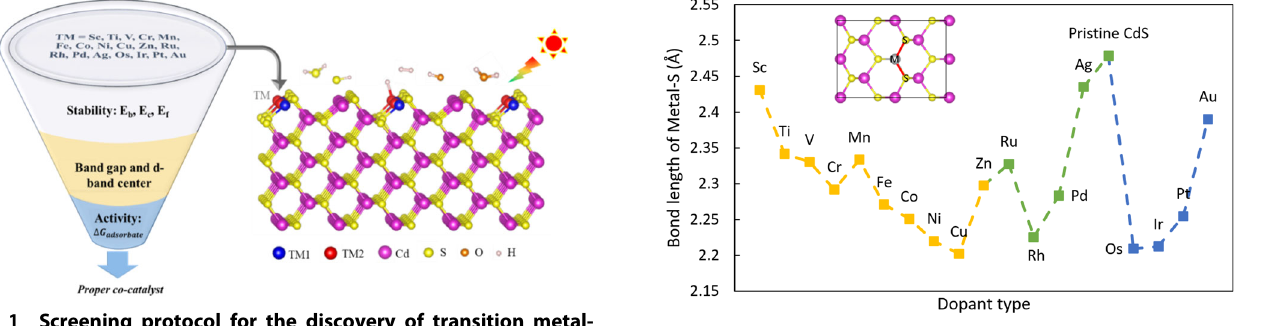
Fig. 2 Bond length between the doped metal and sulfur atoms on the top layer of TM@CdS surfaces. The order of the TM dopant from left to right is as follows: 3d series (yellow), 4d series (green), and 5d series (blue). The dashed line is a guide to the